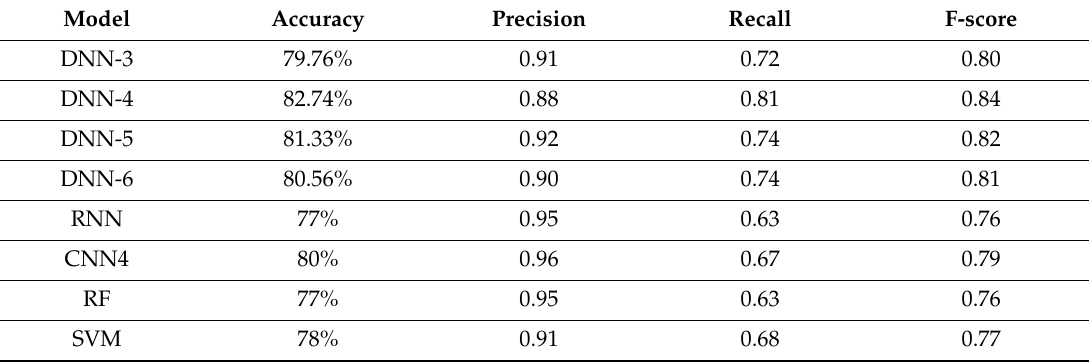
E ff ects of di ff erent DNNs on binary classification, based on NSL-KDD test